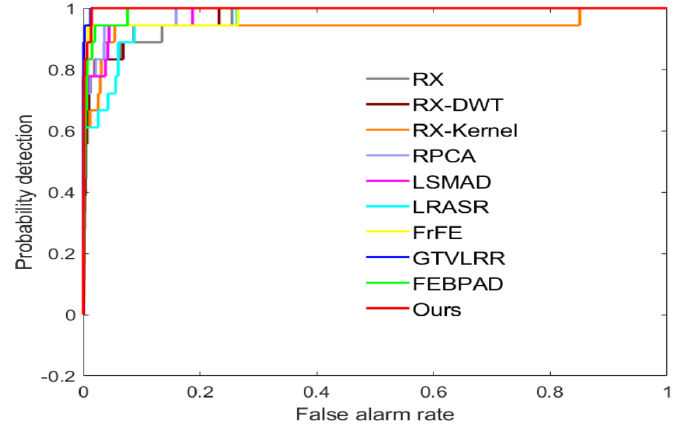
Figure 10. ROC curves of anomaly detectors on the HYDICE dataset.